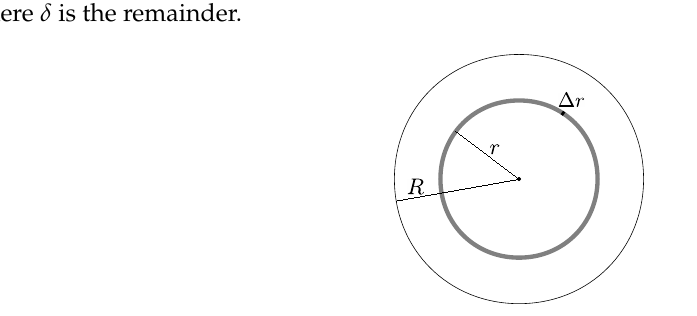
Figure 8. A ring with infinitesimal width ∆ r .